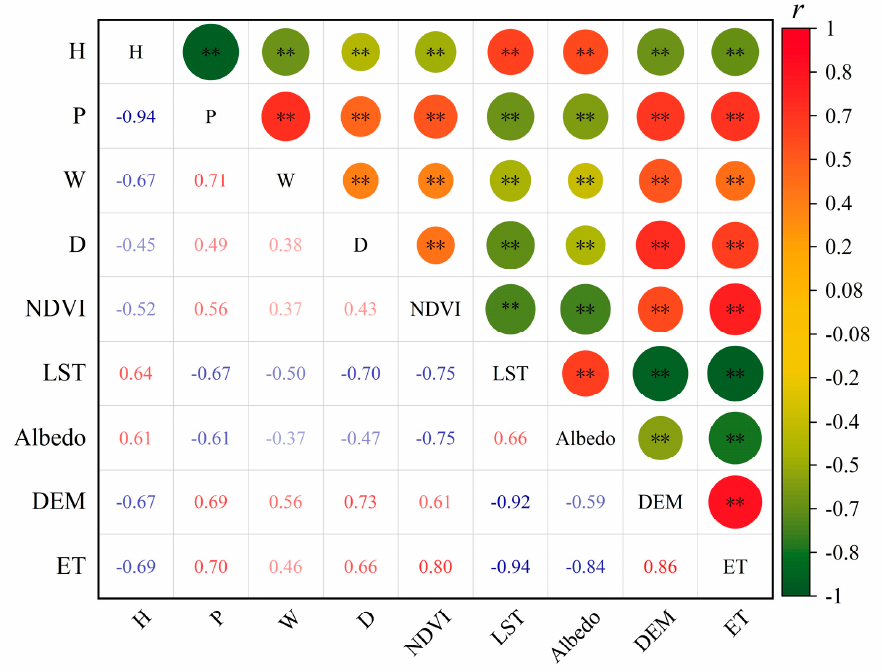
Figure 8. Correlation coe ffi cients between the driving factors. ** represents sig values less than 0.01 ( p < 0.01).